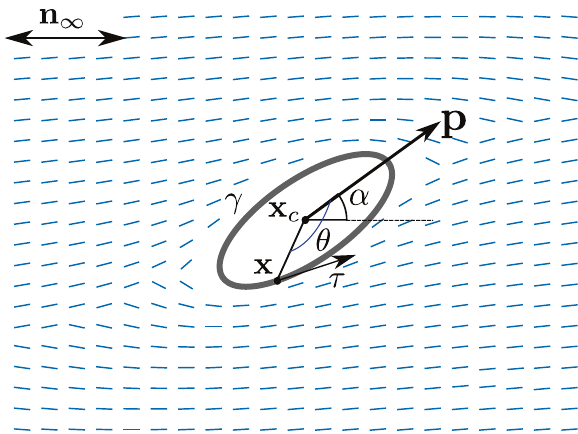
Fig. 1 Schematics of a microswimmer exempli fi ed by a fl agellated bacterium. The domain occupied by the microswimmer is modeled as an ellipse, oriented parallel to the unit vector p . The VELC far- fi eld director orientation is shown by n ∞ . The angle between the horizontal axis and the vector p is given by α . Small blue segments represent the nematic director fi eld. These segments are tangential to the microswimmer ’ s surface, thus illustrating planar